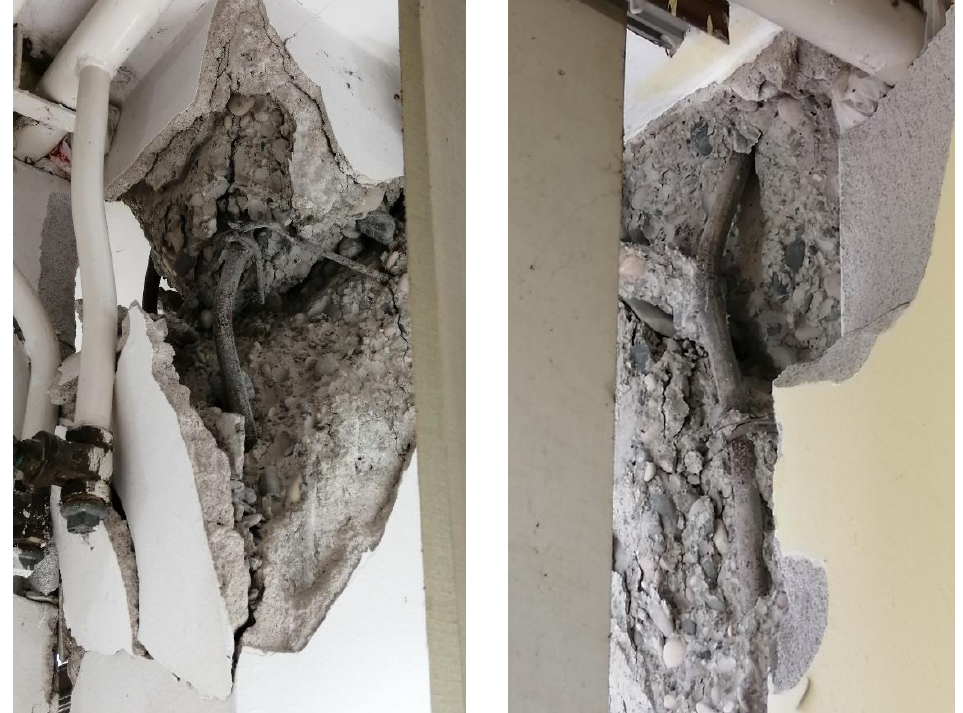
Figure 1. Buckling of plain bar reinforcement on top of the RC piers.